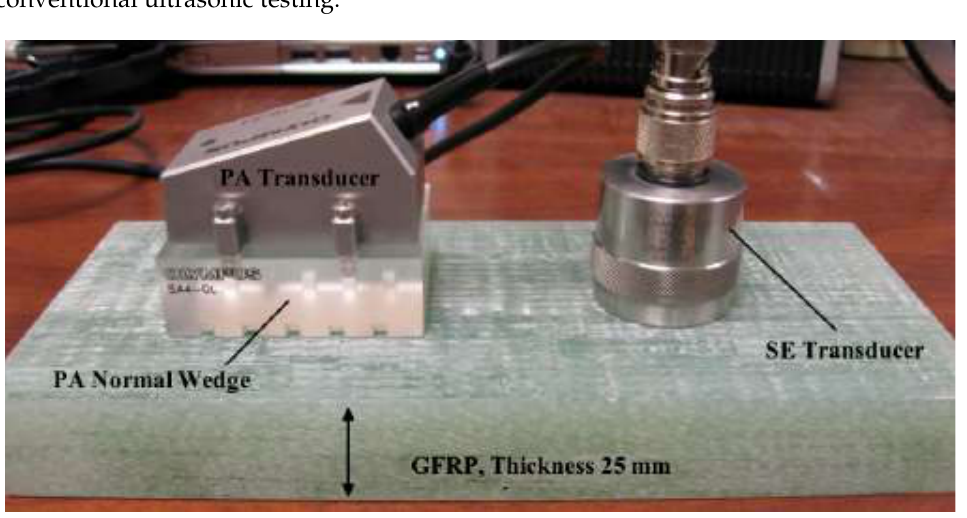
Figure 11. Comparison between phased-array (PA) transducer used in PAUT and a single-element (SE) transducer used in conventional ultrasonic testing, adapted from [33].